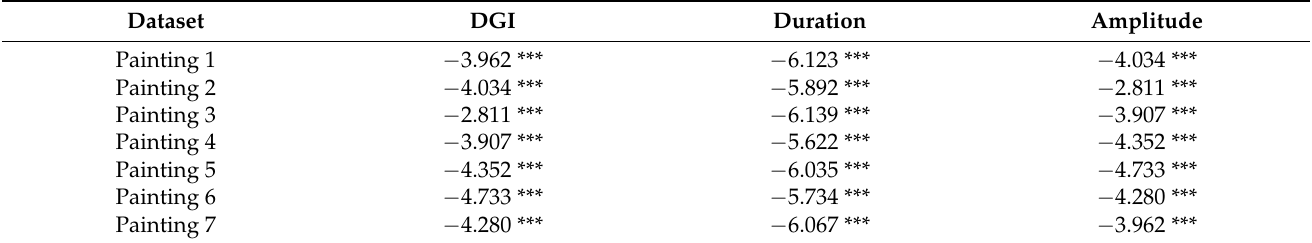
Table 2. Mann–Whitney U test for each of the three-parameter and the seven paintings dataset. (*** indicate a p -value less than